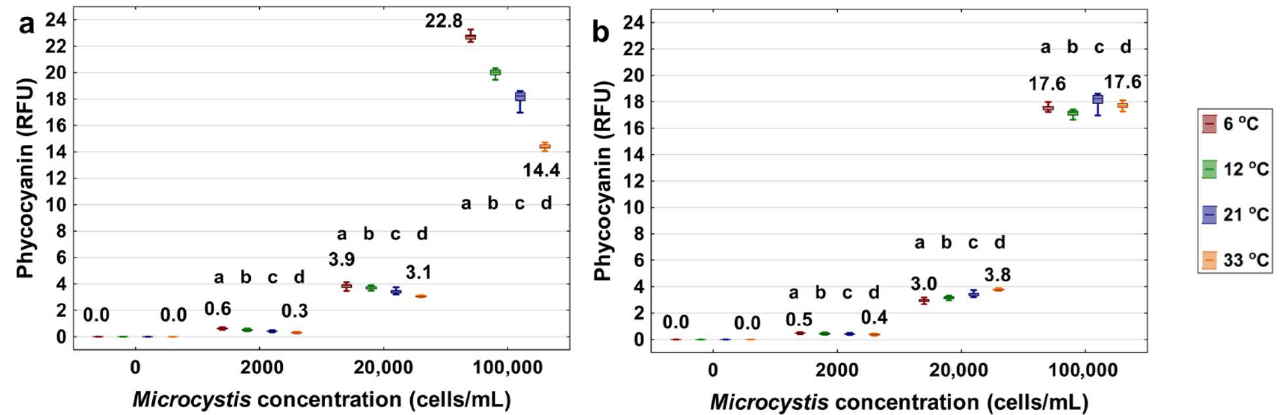
Figure 3. Phycocyanin readings (RFU) with the YSI EXO2 probe of the 0, 2000, 20,000 and 100,000 cells/mL of Microcystis aeruginosa strain CPCC 300 suspended in 6, 12, 21, 33 ◦ C of ul- trapure water. The probe measured each of the samples at a 250 ms interval for 10 min ( a ). In ( b ) the temperature interference was removed by adjusting the raw data to a reference temperature of 21 ◦ C using Equation (3). The bottom and top of each box represent the 25th–75th percentiles, respectively. The whiskers represent the minimum and maximum values. The line within each box corresponds to the median value. Different letters represent significant differences between treatment comparisons (Kruskal–Wallis followed by Dunn’s post hoc test, p ≤